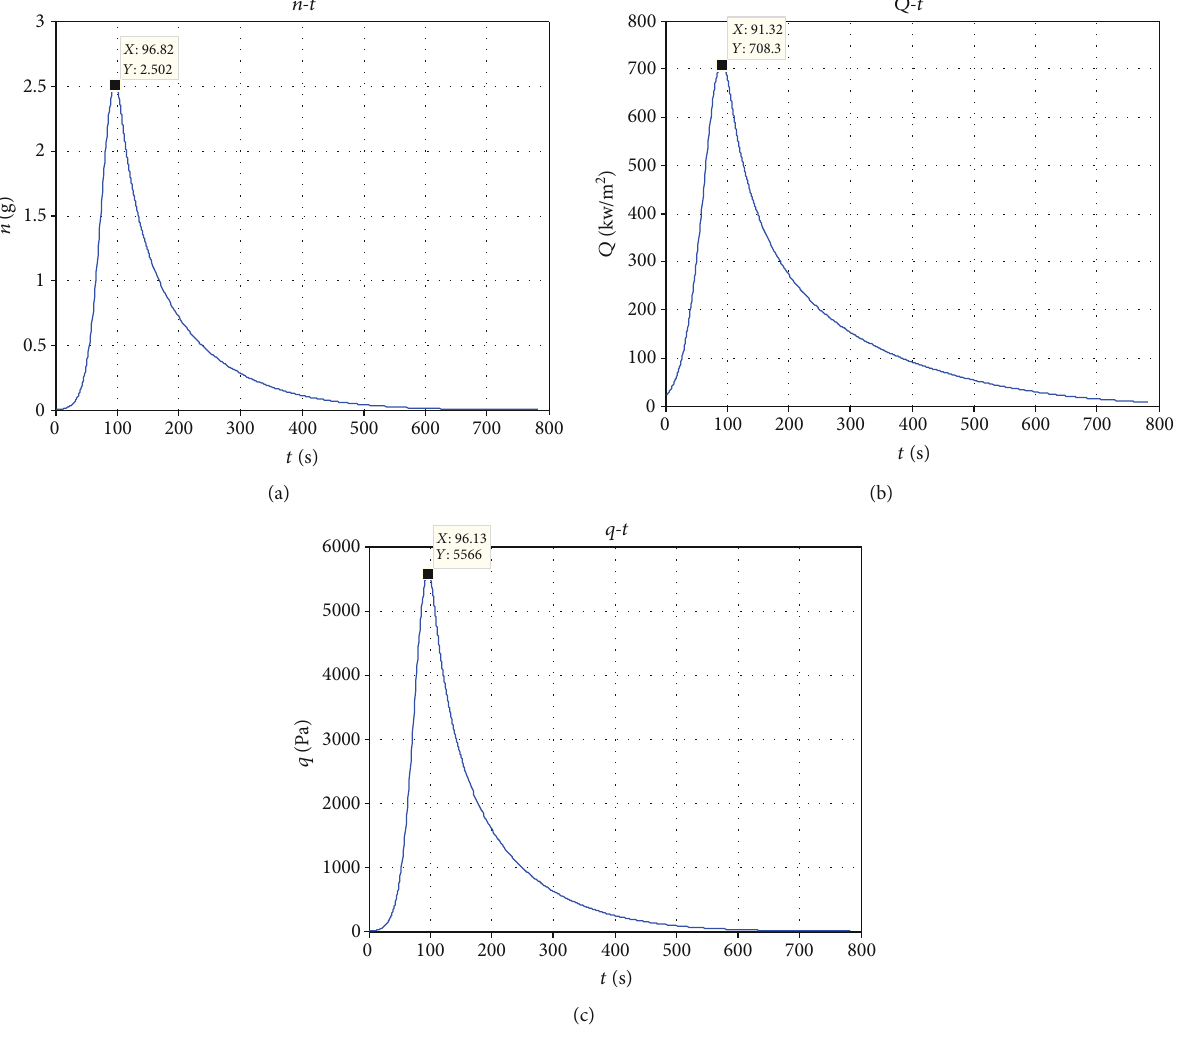
Figure 12: (a) Load, (b) heat rate, and (c) dynamic pressure vs. time t .